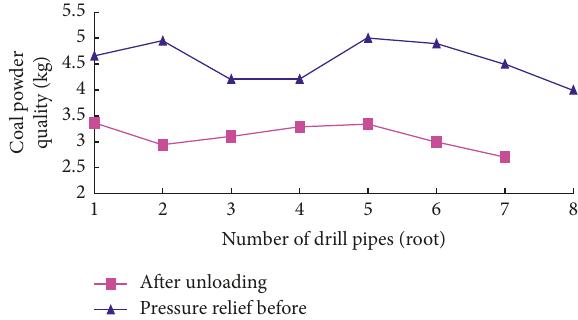
Figure 11: Comparison diagram of coal cutting values before and after blasting pressure